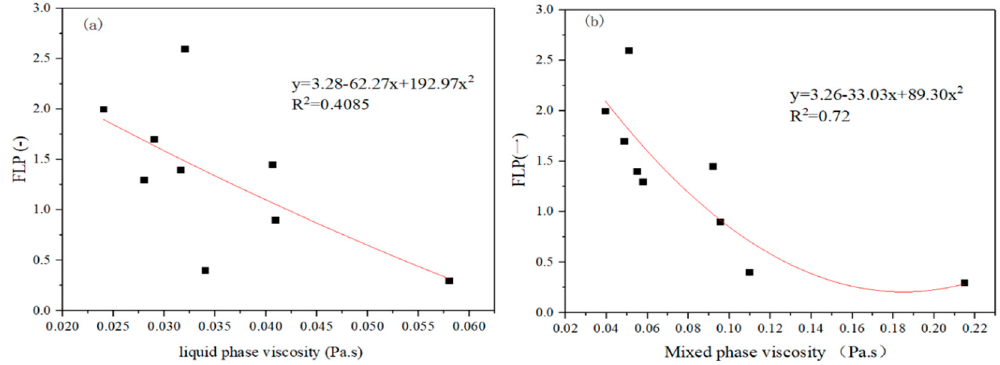
Figure 9. Relationship between FLP and liquid phase viscosity: ( a ) pure liquid viscosity and ( b ) mixed phase viscosity.